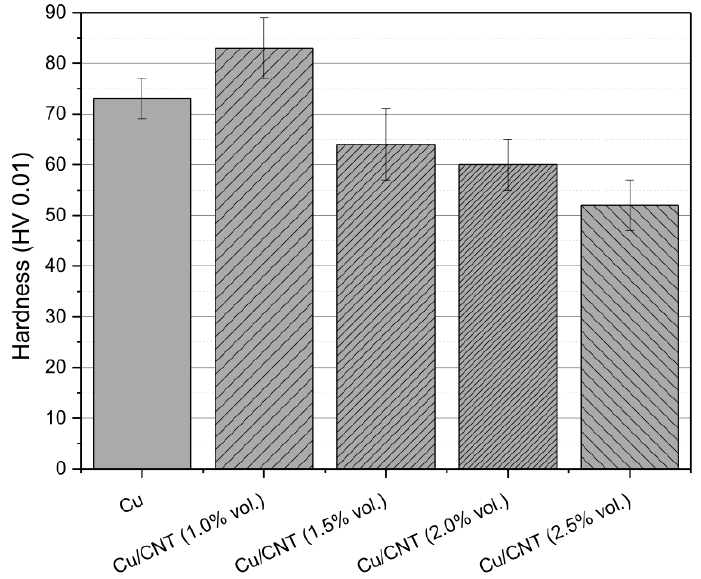
Figure 5. Evolution of the microhardness of Cu/CNT nanocomposites with the fraction of CNTs.